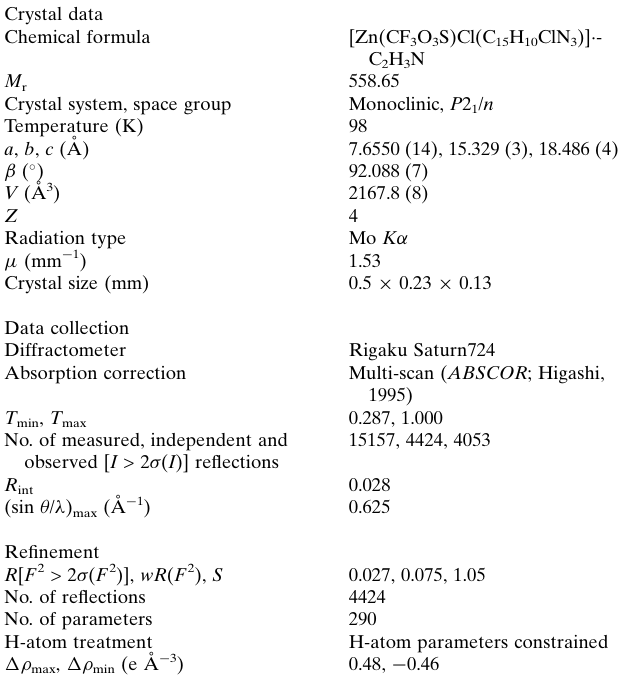
Table 2 Experimental